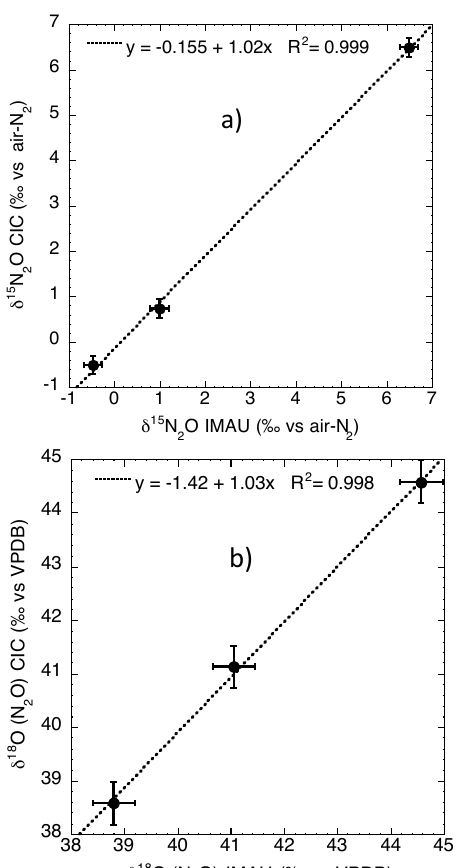
Fig.5: N 2 O isotope results of three air cylinders measured at IMAU and CIC. a) Fig. 5. N 2 O isotope results of three air cylinders measured at IMAU and CIC. (a) δ 15 N (b) δ 18 O. The dotted line represents the best O. The dotted line represents the best fit.